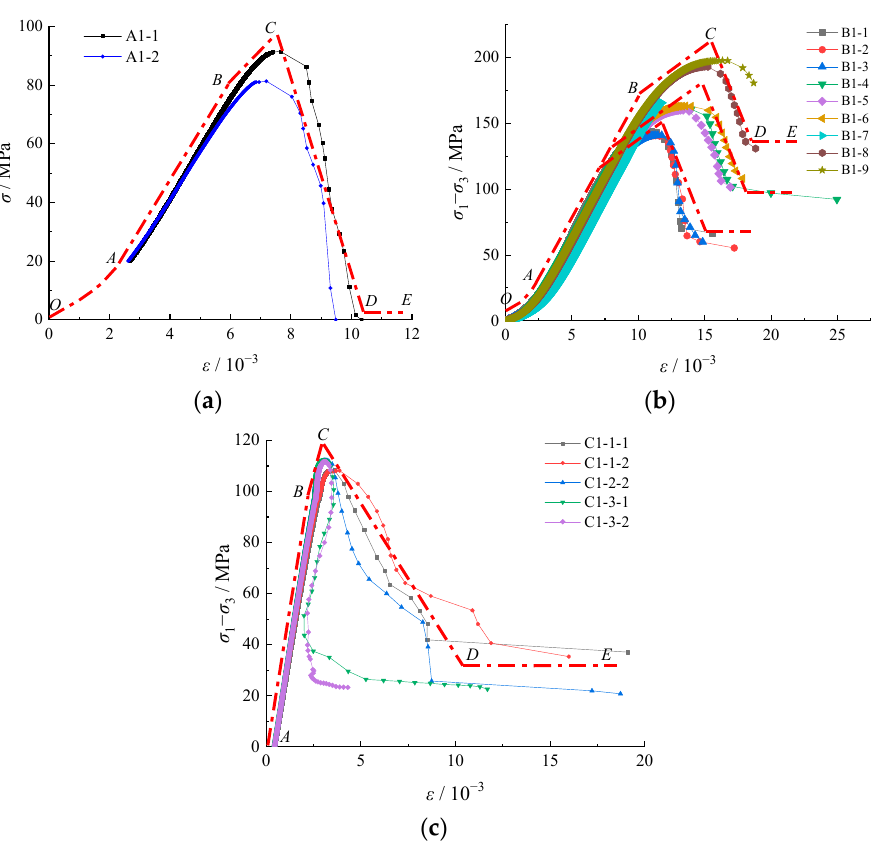
Figure 6. Stress-strain curve and mechanical turning point. Since the specimens were compacted before the application of the confining pressure and the hydraulic pressure in the conventional triaxial compression test, the compaction stage was excluded from this study. A multi-linear, strain-softening model of cementitious sandstone was established. ( a ) Uniaxial compression. ( b ) Conventional triaxial compression. ( c ) A constant axial pressure and an unloading confining pressure.